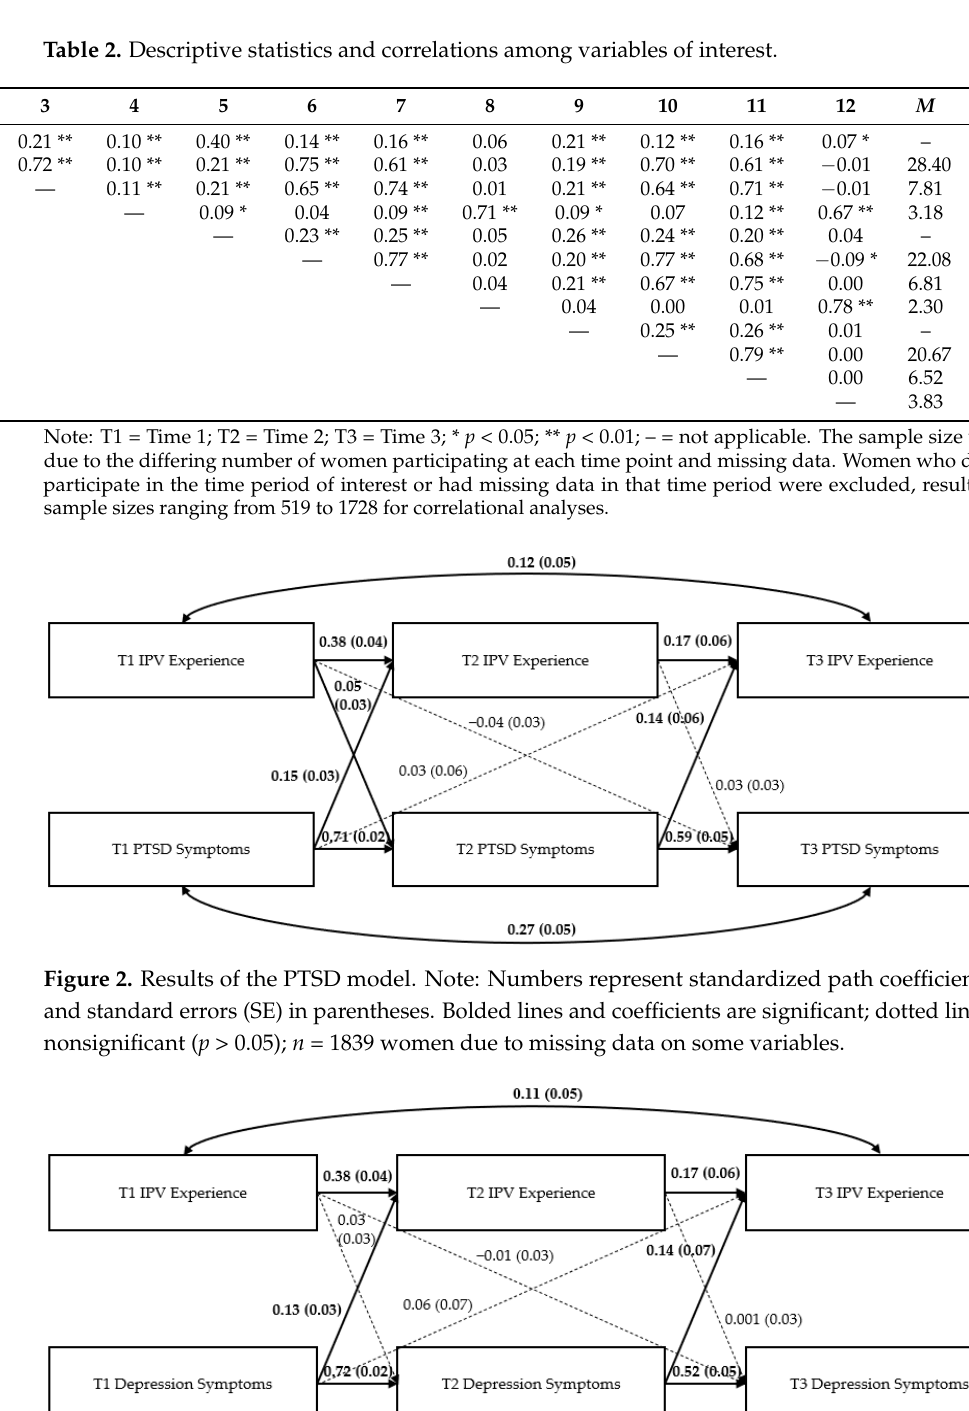
Figure 4. Results of the alcohol use model. Note: Numbers represent standardized path coefficients (β) and standard errors (SE) in parentheses. Bolded lines and coefficients are significant; dotted lines are nonsignificant ( p > 0.05); n = 1841 women due to missing data on some variables. 4. Discussion This longitudinal study furthers our understanding of the associations between mental health and IPV risk by examining whether PTSD symptoms, depression symptoms, and alcohol use predict subsequent IPV experience among a large sample of women veterans. Results partially supported our hypotheses. We found that higher PTSD and depression symptoms were both consistently associated with IPV experience over time, whereas alcohol use was not. Although IPV experience was consistently associated with PTSD and depression symptoms in bivariate analyses, IPV was not associated with subsequent depression symptoms or alcohol use in the path analyses. We did find some support for a causal relationship between IPV experience and subsequent PTSD symptoms; however, that relationship only held between T1 and T2, not between T2 and T3. Thus, it appears that prior PTSD and depression symptoms account for a significant amount of the variance in future PTSD and depression symptoms, which may be absorbing any effects of prior IPV experience on mental health in this sample. Moreover,